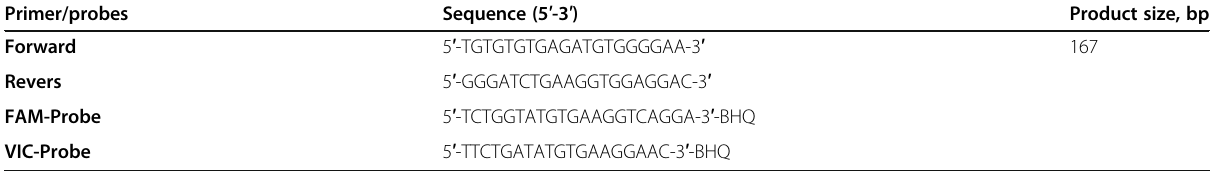
Table 1 Primers and probes of ApoB gene polymorphism (rs676210) used in the study